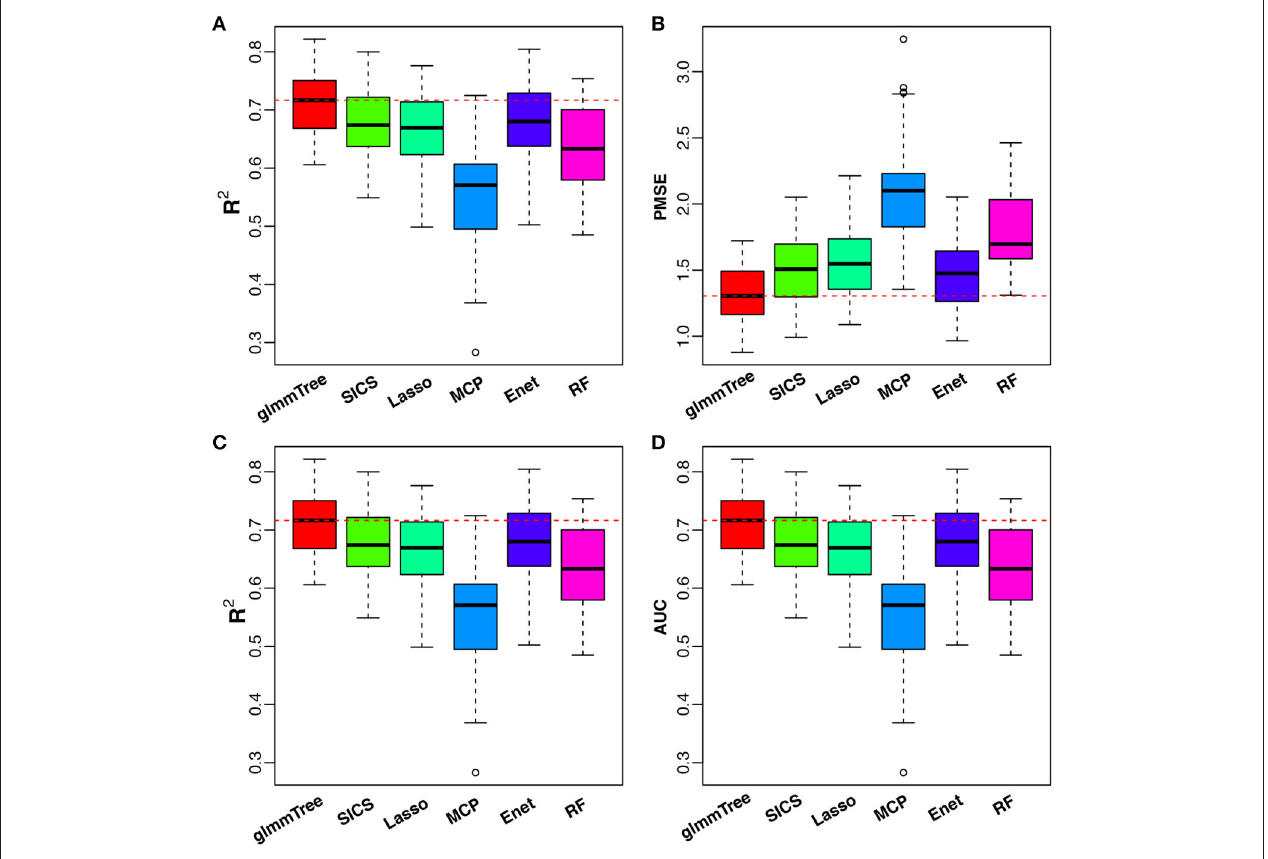
FIGURE 6 | Performance comparison for age prediction. All USA samples are used in continuous age prediction (A,B) . Binary prediction is based on the two age groups: baby (0 to 3 years old) and child (3 to 18 years old) (C,D) . Red dashed line indicates the median value of various performance measures for